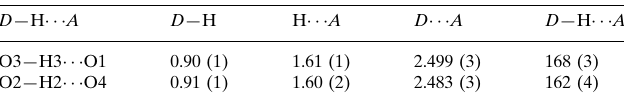
Hydrogen-bond geometry (A˚ , (cid:5)